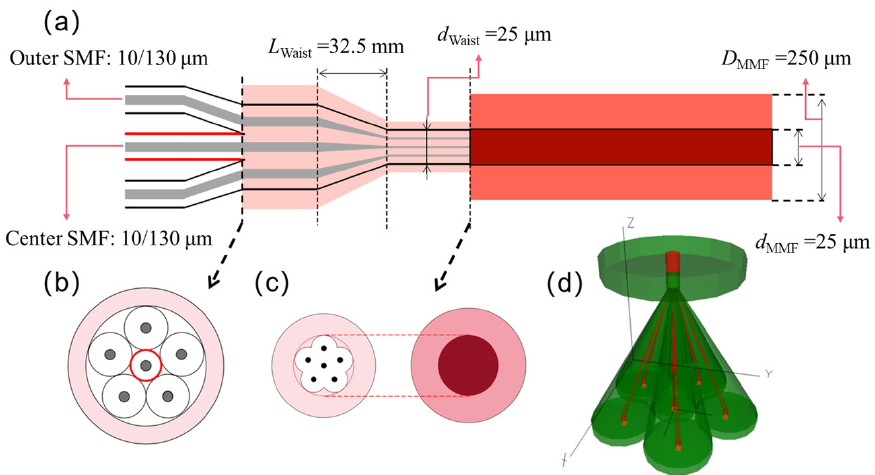
Figure 2. Geometrical structure of a 6 × 1 photonic lantern. ( a ) Sectional view of the 6 × 1 photonic lantern; ( b ) sectional view of the photonic lantern without the pulling cone; ( c ) sectional view of the fusion plane between the photonic lantern and the connecting multimode fiber; and ( d ) 3D modeling of the 6 × 1 photonic lantern where the red region is the fiber core and the green region is the cladding area.